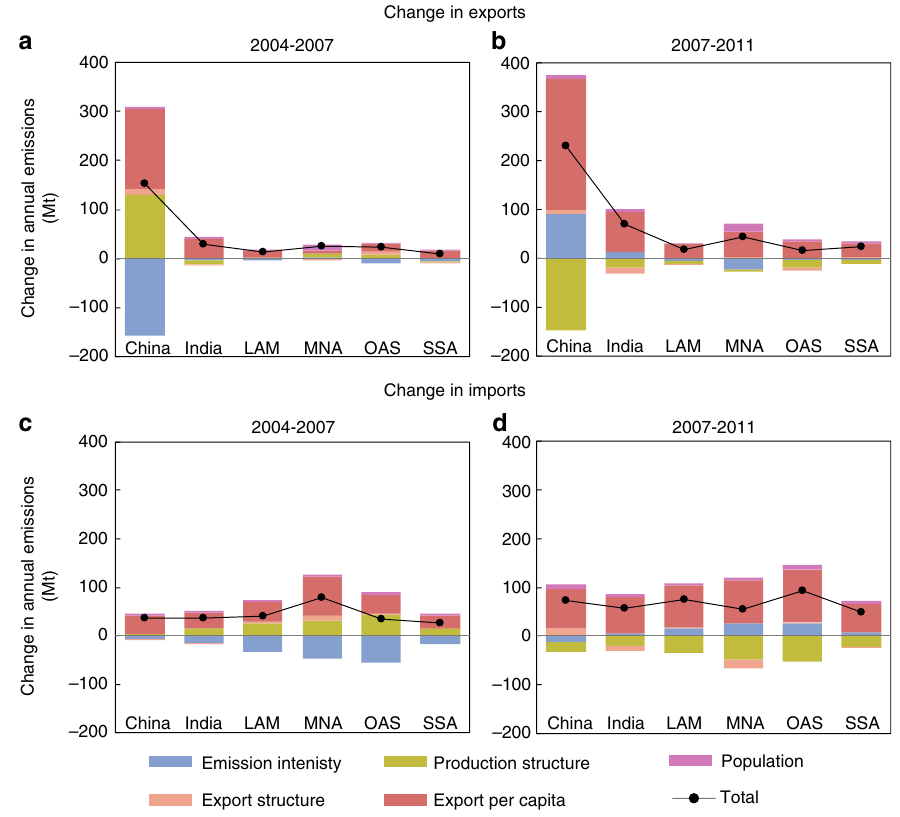
Fig. 2 Contributions of different factors to changes in emissions embodied in trade. Bars show the contribution of factors to change in exports during 2004 – 2007 ( a ) and 2007 – 2011 ( b ), and change in imports during 2004 – 2007 ( c ) and 2007 – 2011 ( d ). The developing regions are aggregated into 6 regions, as shown in Supplementary Table 3. Columns show the contributions of different driving